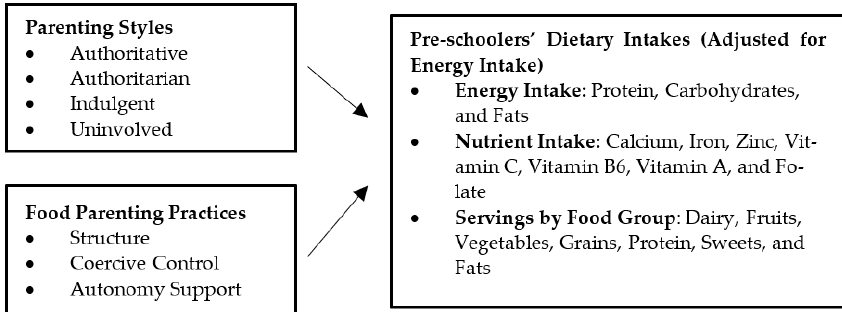
Figure 1. The current study model of parenting styles, food parenting practices and preschoolers’ dietary intakes.